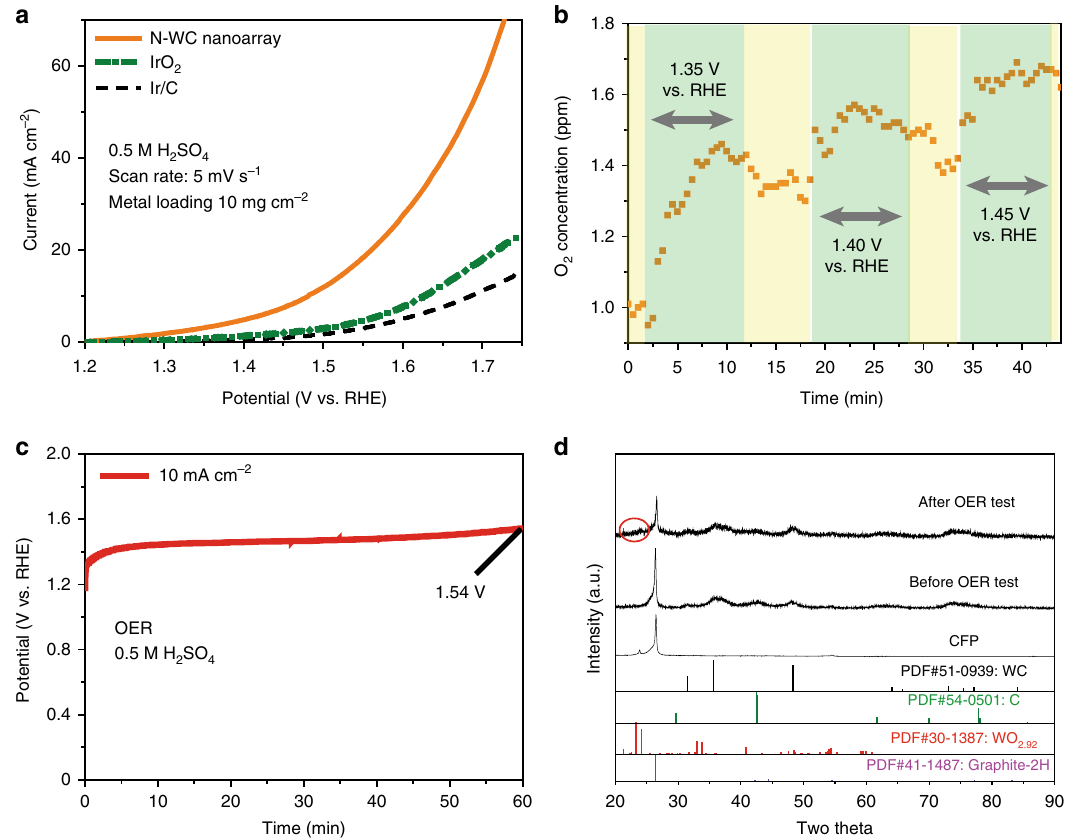
Fig. 6 OER performance and comparison. a OER polarization curves tested in 0.5 M H 2 SO 4 of N-WC nanoarray, IrO 2 , and 20 wt.% Ir/C at a scan rate of 5 mV/s with iR correction. b O 2 concentration in 0.5 M H 2 SO 4 when different potentials are intermittently applied to N-WC nanoarray electrode. c Stability test of N-WC nanoarray for OER at 10 mA cm − 2 . d XRD patterns of N-WC nanoarray before and after OER